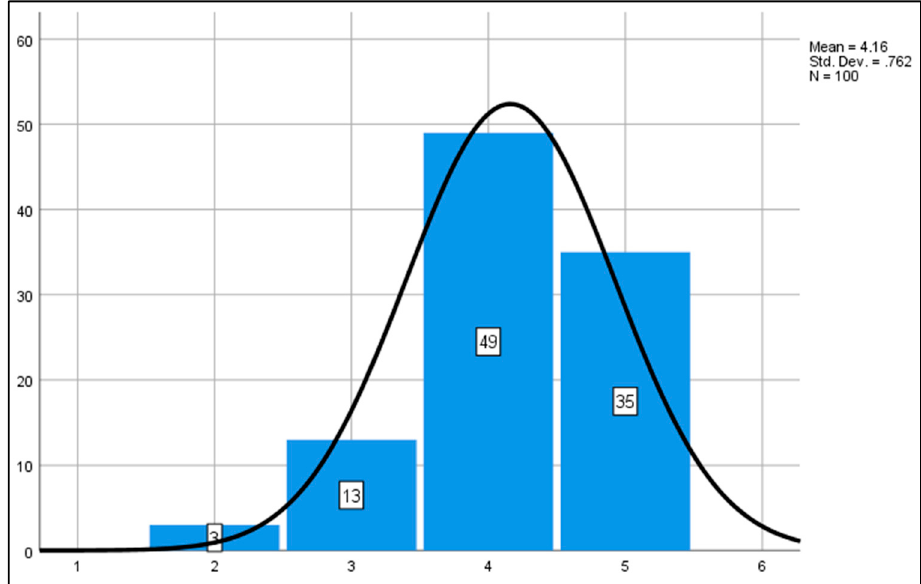
Figure 8 . Risk-taking and Industry 4.0 readiness.